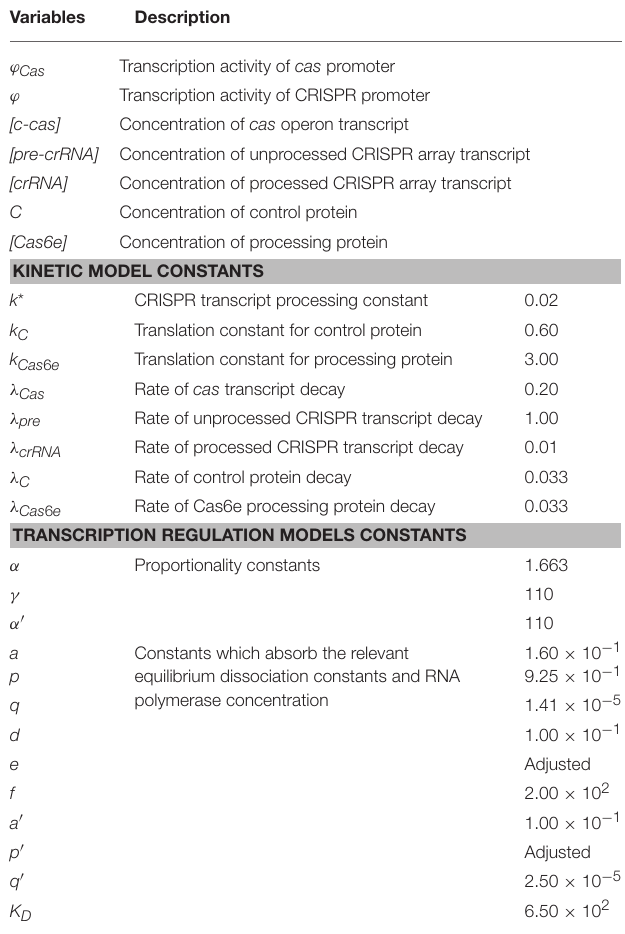
TABLE 1 | Notations used in model